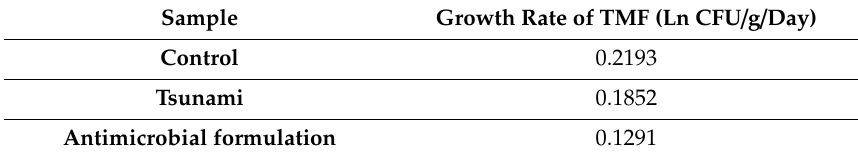
Figure 1. Total mesophilic flora ( a ) and total molds and yeasts ( b ) growth on pre-cut carrots. Table 6. Growth rate of total mesophilic flora (TMF) in refrigerated pre-cut